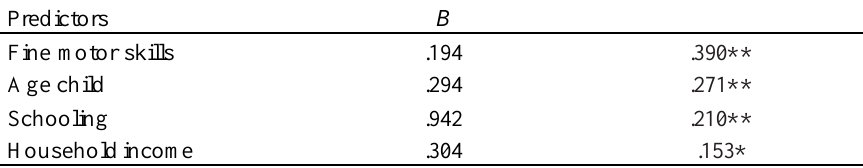
Selected Predictors for Cognitive Functioning Predictors B